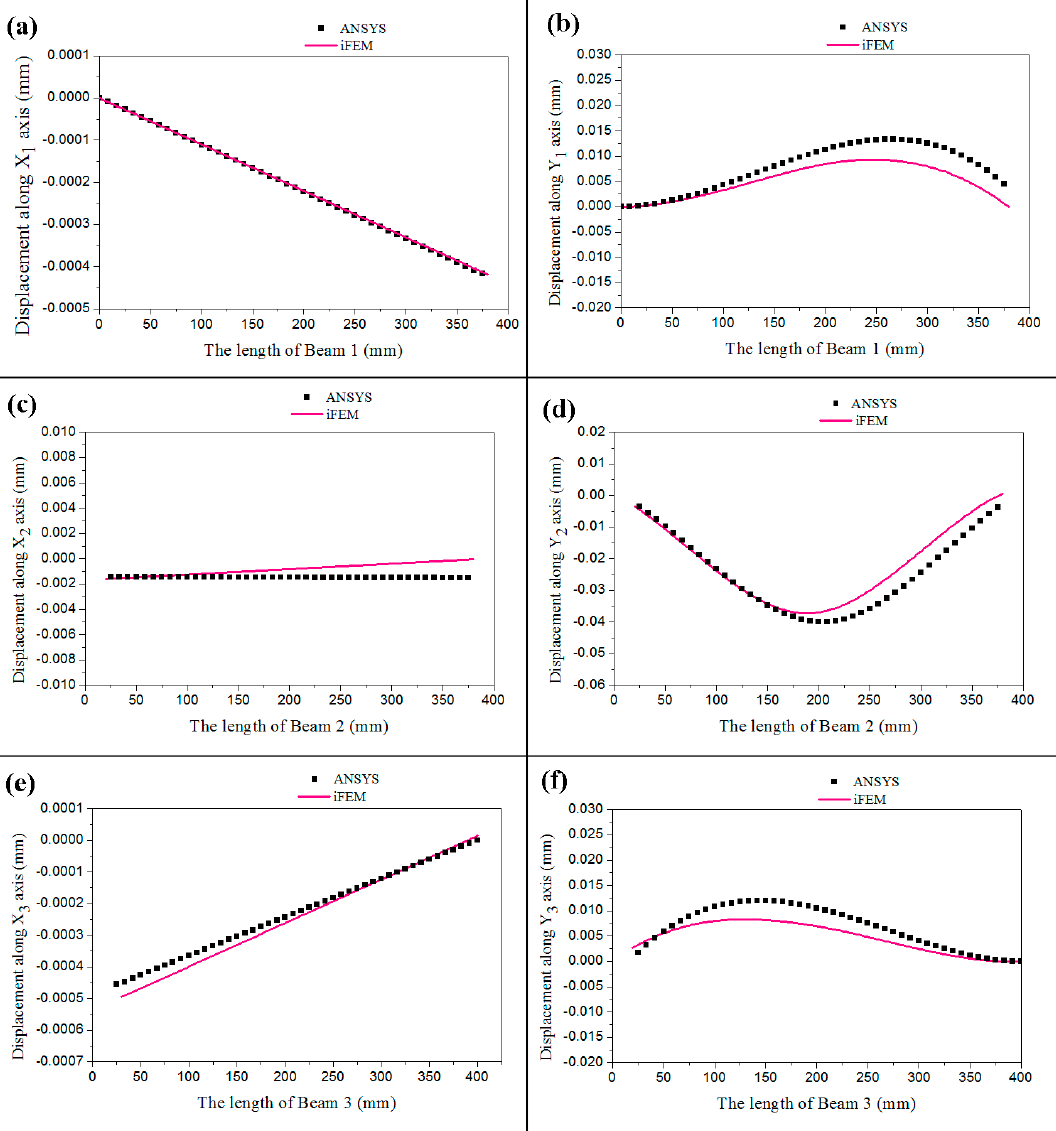
Figure 10. The experimental results. ( a ): The displacement of Beam 1 along x-axis; ( b ): The displacement of Beam 1 along y-axis; ( c ): The displacement of Beam 2 along x-axis; ( d ): The displacement of Beam 2 along y-axis; ( e ): The displacement of Beam 3 along x-axis; ( f ): The displacement of Beam 3 along y-axis.